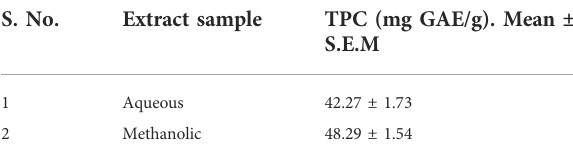
TABLE 2 The total phenolic content in P. gemini fl orum methanolic and leaf extract. S.